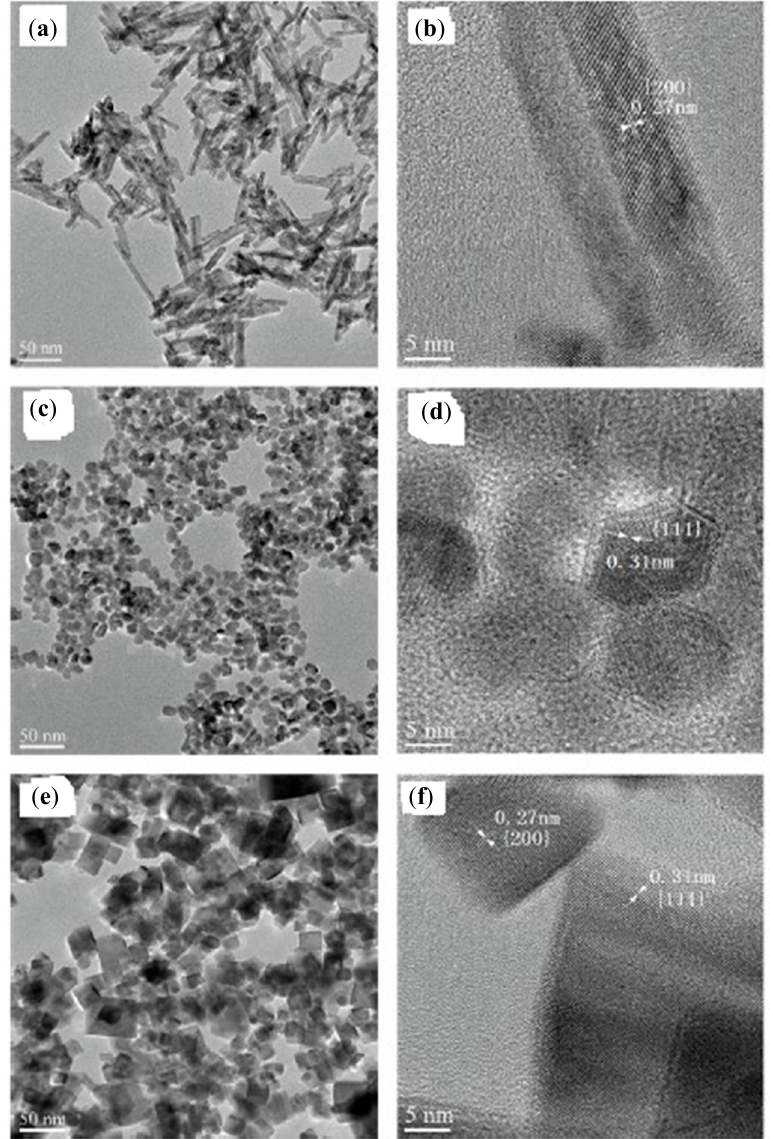
Figure 4. TEM (Transmission electron microscope) and HRTEM (High-resolution transmission electron microscope), images of: Au-Pd / CeO 2 -rod ( a,b ); Au-Pd / CeO 2 -polyhedron ( c , d ); and Au-Pd / CeO 2 -cube ( e,f ) catalysts. Figure from Ref. [90], Copyright 2020, Elsevier.